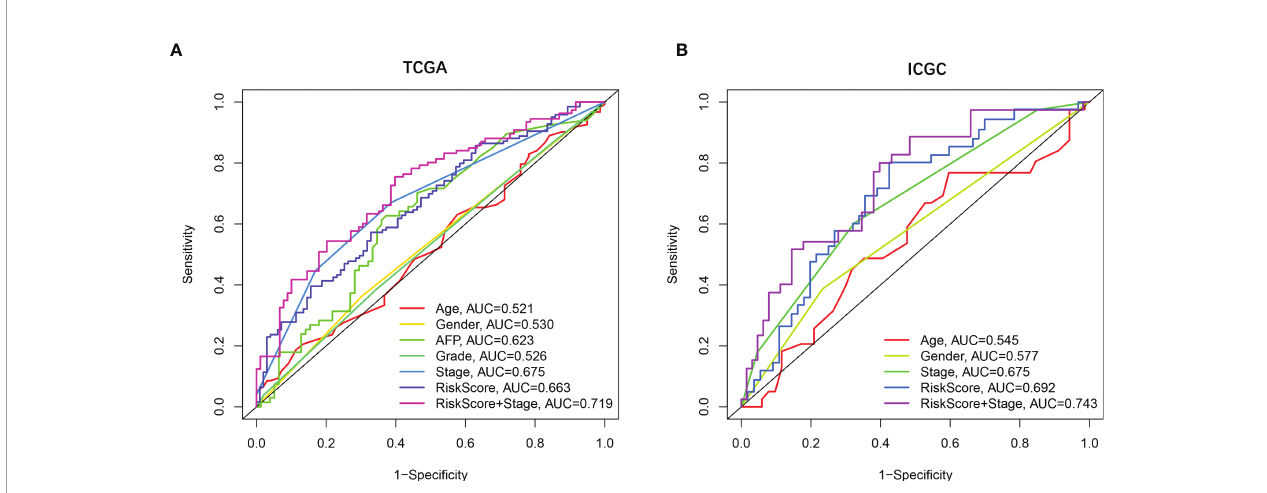
FIGURE 4 | The prognostic value validated by multi-index ROC curves. (A) TCGA cohort, n = 365, curves in different colors represent time-dependent ROC of age, gender, AFP, grade, stage, risk score, and risk score with stage variables, respectively. (B) ICGC cohort, n = 231, curves in different colors represent time- dependent ROC of age, gender, stage, risk score, and risk score with stage variables,